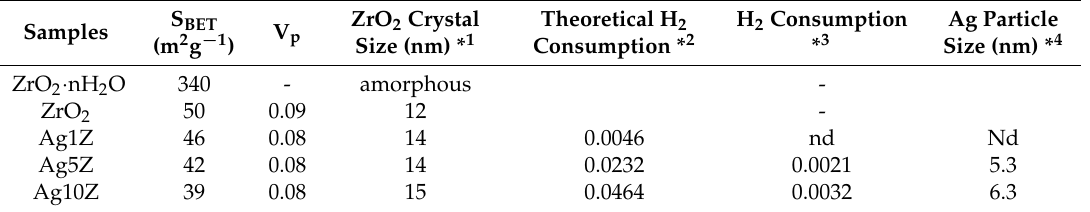
Table 1. Specific surface area, TPR results and crystalline phases of the studied